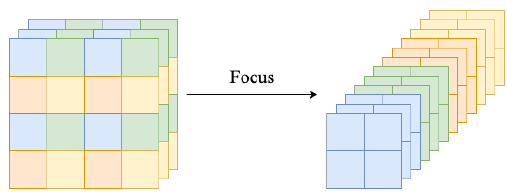
Figure 6. Structure of